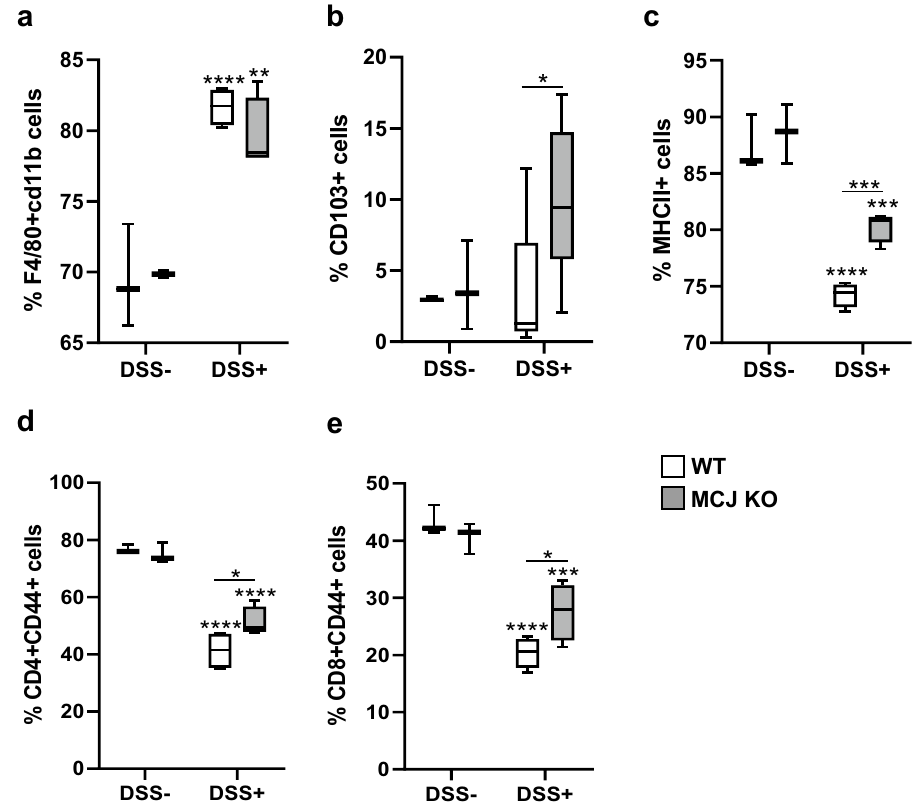
Figure 3. Characterization of cellular immune responses in murine DSS-induced chronic colitis model. Flow cytometry analysis of lymphoid populations in mesenteric lymphoid nodes, shown as percentage. ( a ) F4/80 + CD11b macrophages, ( b ) CD103 + dendritic cells, ( c ) MHCII + antigen presenting cells, ( d ) CD4 + CD44 + effector/memory T and ( e ) CD8 + CD44 + effector/memory T cells. Statistical differences. Box and whisker plots of median, quartiles and range, n = 4 mice per group at a minimum. For statistical analysis two-way ANOVA was used as applicable, * P < 0.05, ** P < 0.01, *** P < 0.001, **** P < 0.0001. “*” above boxes versus control genotype (DSS- versus DSS +), “*” above line versus different genotypes in the same experimental